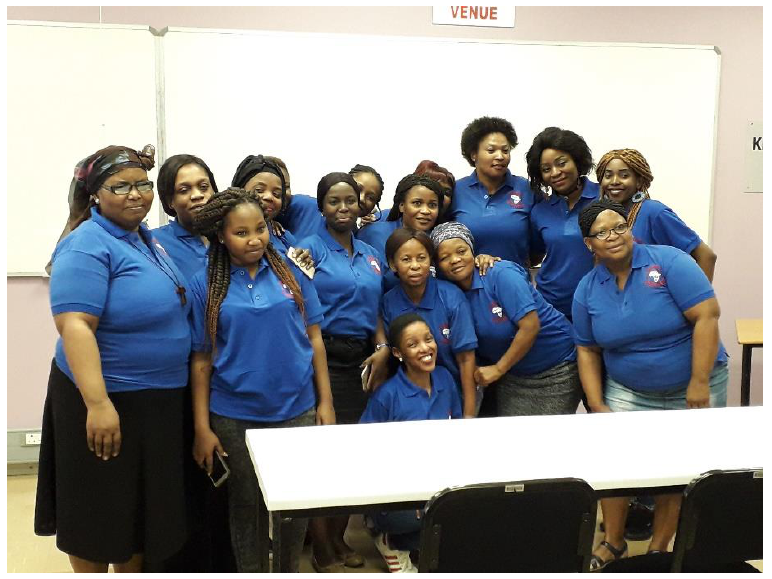
Figure 2 : Thusa Batho participants at the business workshop. Photograph: K. Mchunu. Theorising transformational learning and inclusive social